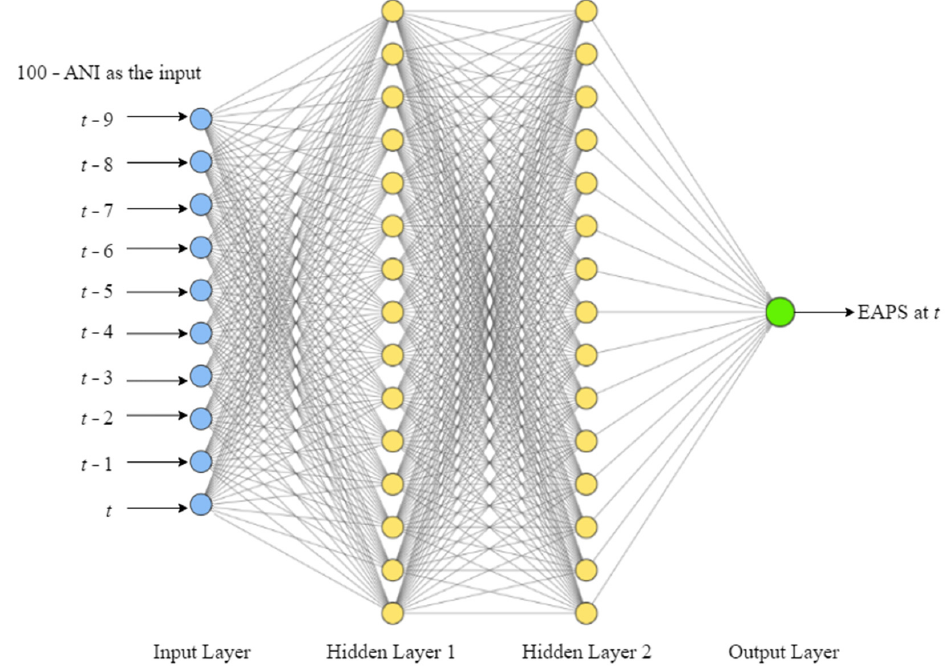
Figure 11. Illustration of the MLP model